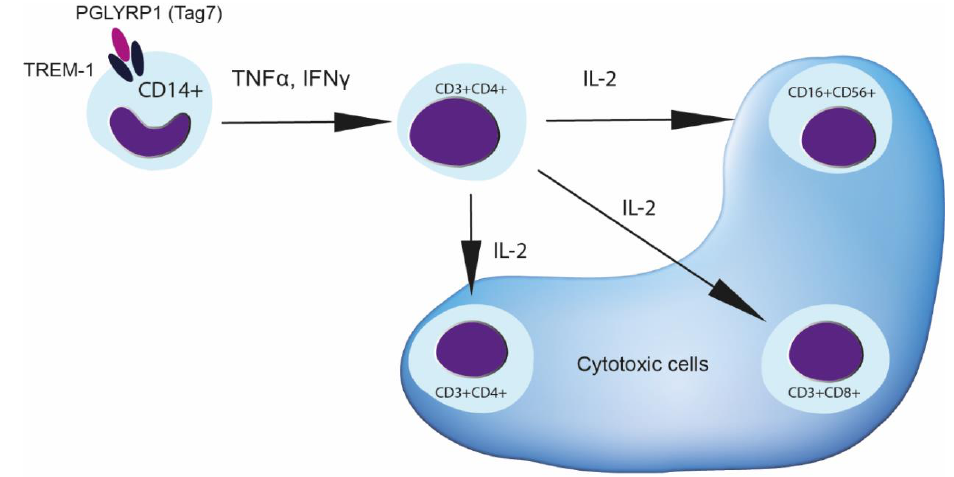
Figure S1: Changes in cytotoxic activity of di ff erent lymphocyte subpopulations induced in PBMC incubated with Tag7 (10 –9 M) for di ff erent periods of time. Figure S2: Secretion of IL-2 by CD3 + CD4 + lymphocytes incubated with TNF α or IFN γ for 24 and 48 h. CD3 + CD4 + -lymphocytes were isolated by magnetic cell separation from PBMC on day 0 and treated with TNF α or IFN γ . Figure S3: Cytotoxicity Tag7-PBMC in the presence of specific antibodies to TNF α , IFN γ and